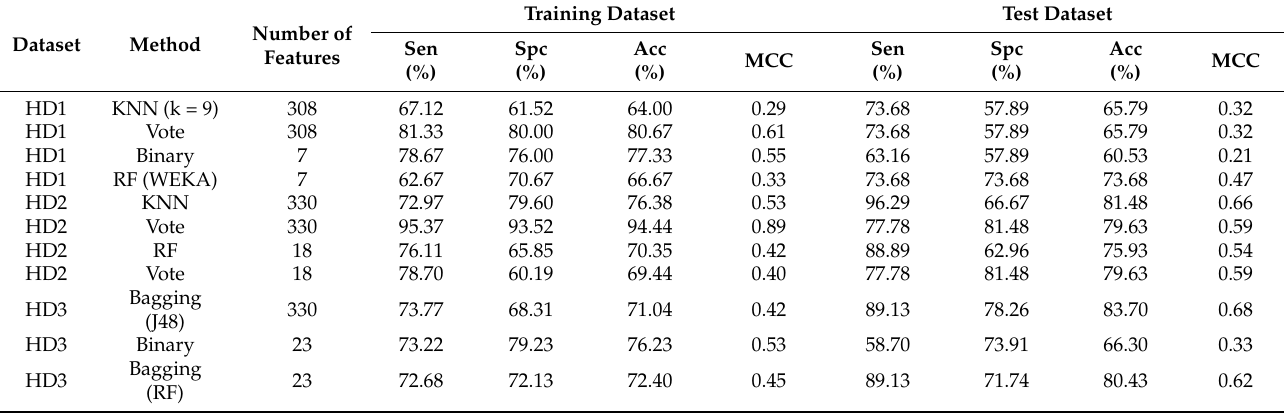
Table 3. In the hemolytic peptide dataset HD1, HD2 and HD3, the better performance model is developed according to various algorithms and different